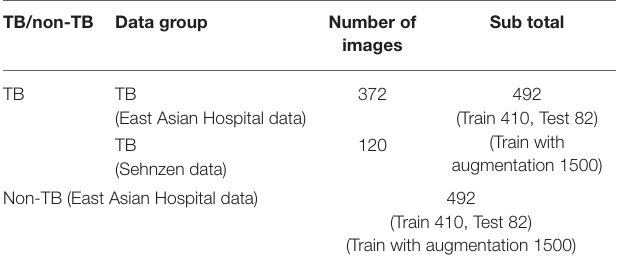
TABLE 2 | Data structure for AXIR2.